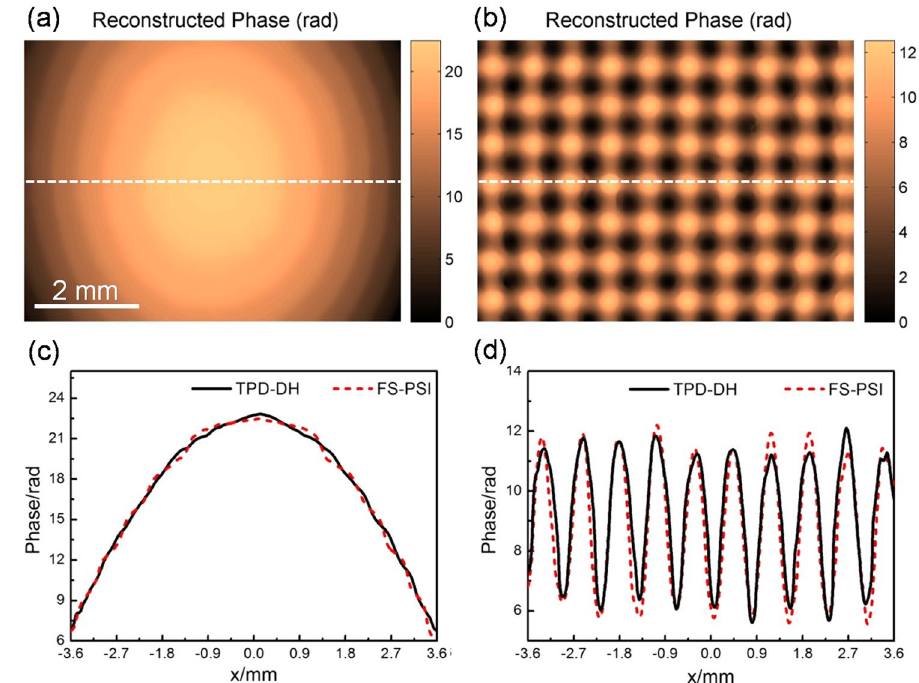
Figure 4. Comparison between TPD-DH in microscopy and conventional FS-PSI. ( a ) and ( b ) phase distribution of the setup and micro-lens array measured by using FS-PSI; ( c ) and ( d ) intensity distributions along the line denoted in Fig. 4 (a ) and (b), and their counterparts in Fig. 3. Figure 4 (a) and (b) are exactly the same size.